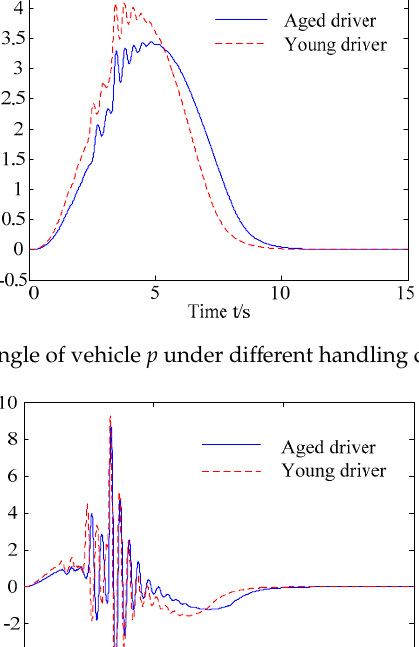
Figure 24. Yaw rate of vehicle p under different handling characteristics.